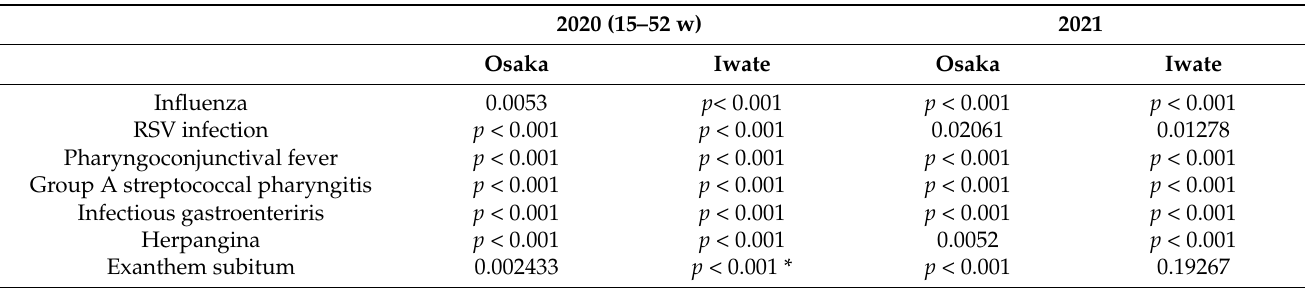
Table 2. Test of 5-week moving averages over the past 5 years and the number of patients reported during the COVID-19 pandemic.